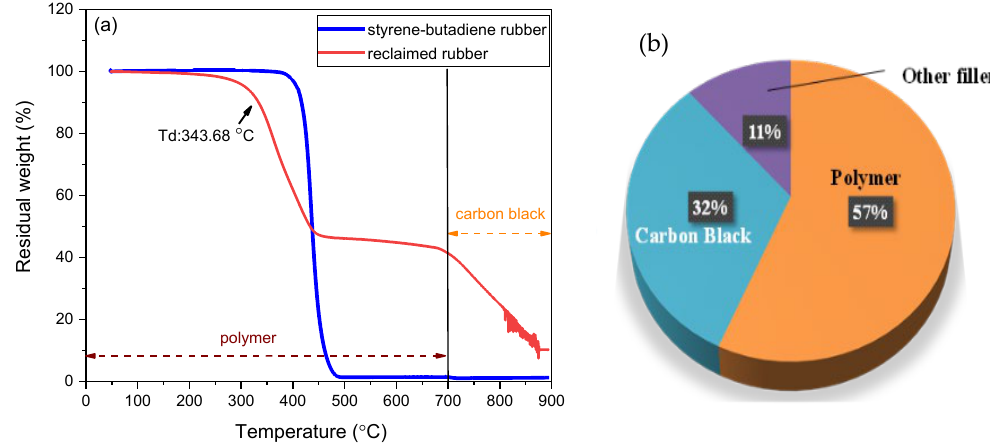
Figure 3. ( a ) TGA curve of commercial styrene–butadiene rubber and reclaimed rubber and ( b ) approximate weight composition of reclaimed rubber sample.